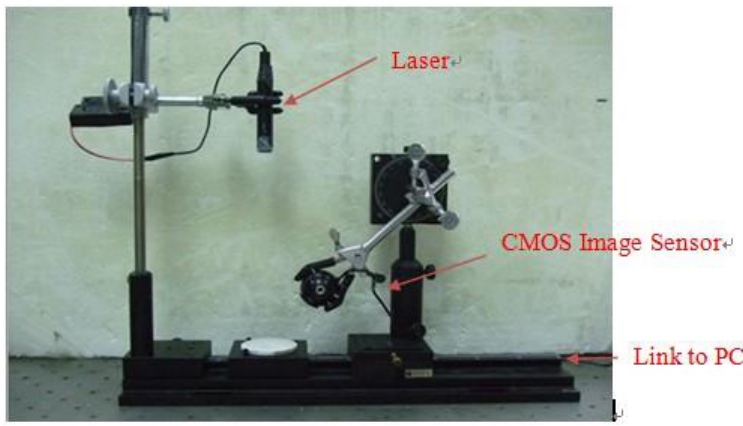
Figure 2. Actual implementation of the proposed